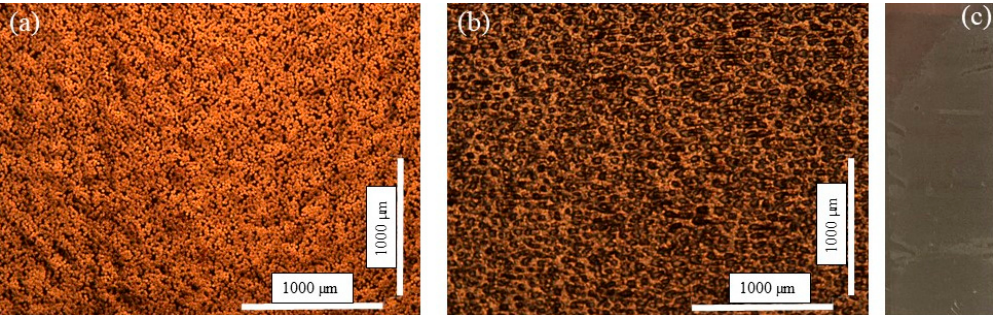
Figure 8. Optical microscopy images of printed Ag patterns after five passes ( a ) before and ( b ) after the removal of the adhesion tape. ( c ) Photograph of the Ag surface where the adhesive part of the tape was attached.